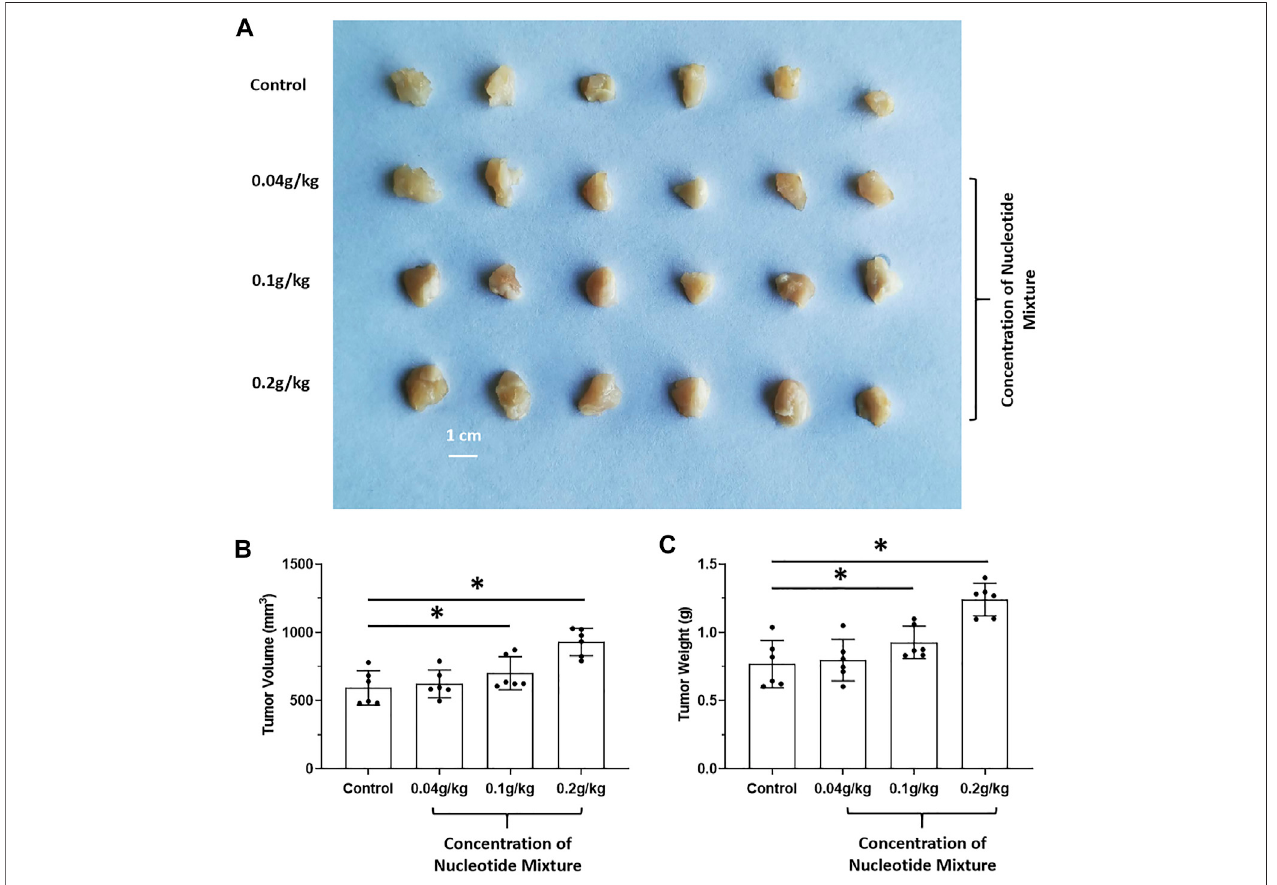
FIGURE 3 | Tumorigenic effect of the SNM alone on human HCC cells in immunode fi cient mice. MHCC97-H cells were obtained by culture. Then, cells were inoculatedintoSCIDmicesubcutaneously.Next,micewereadministered(p.o.)theSNM(0.04,0.1,0.2 g/kg).Aphotographofasubcutaneoustumor (A) andthetumor volume (B) tumor weights (C) are shown. * p <